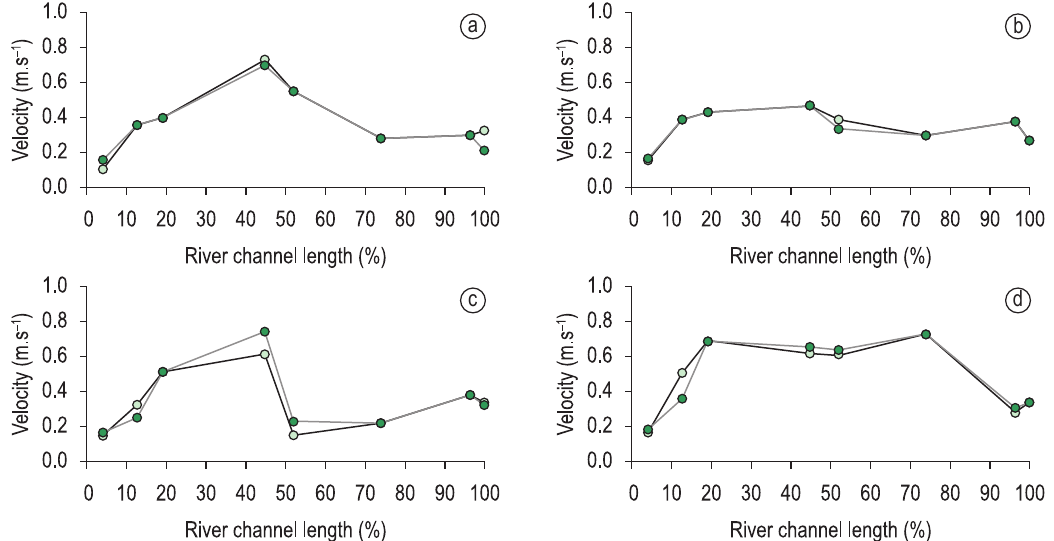
Figure 3. Velocity variation (m/s) in Canha River, during the spring (a - September), summer (b - January), autumn (c - April) and winter (d - July) periods, respectively. ● : observed velocity; “ ● ”: simulated velocity.